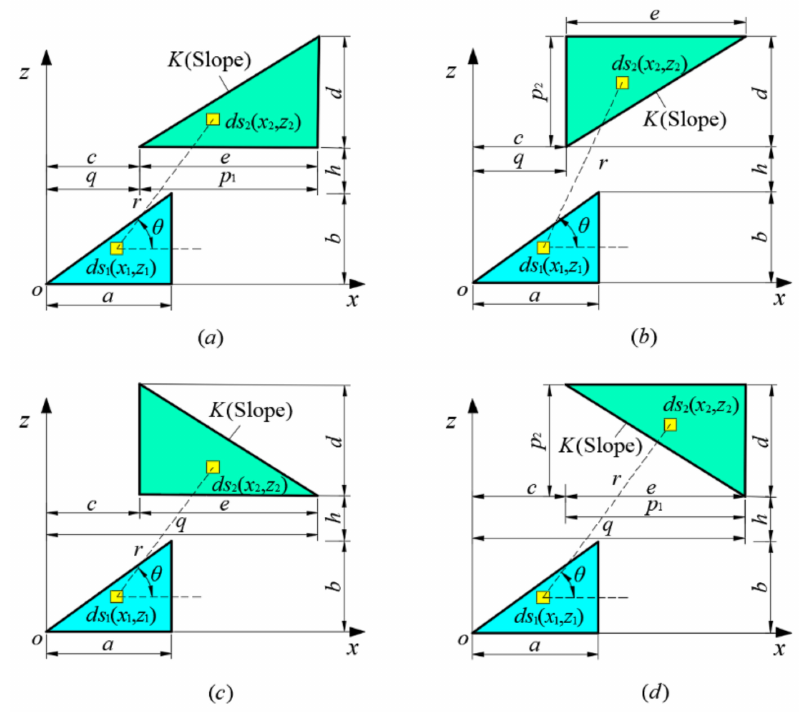
Figure 8. Schematic diagram of triangular–triangular CPMUs.